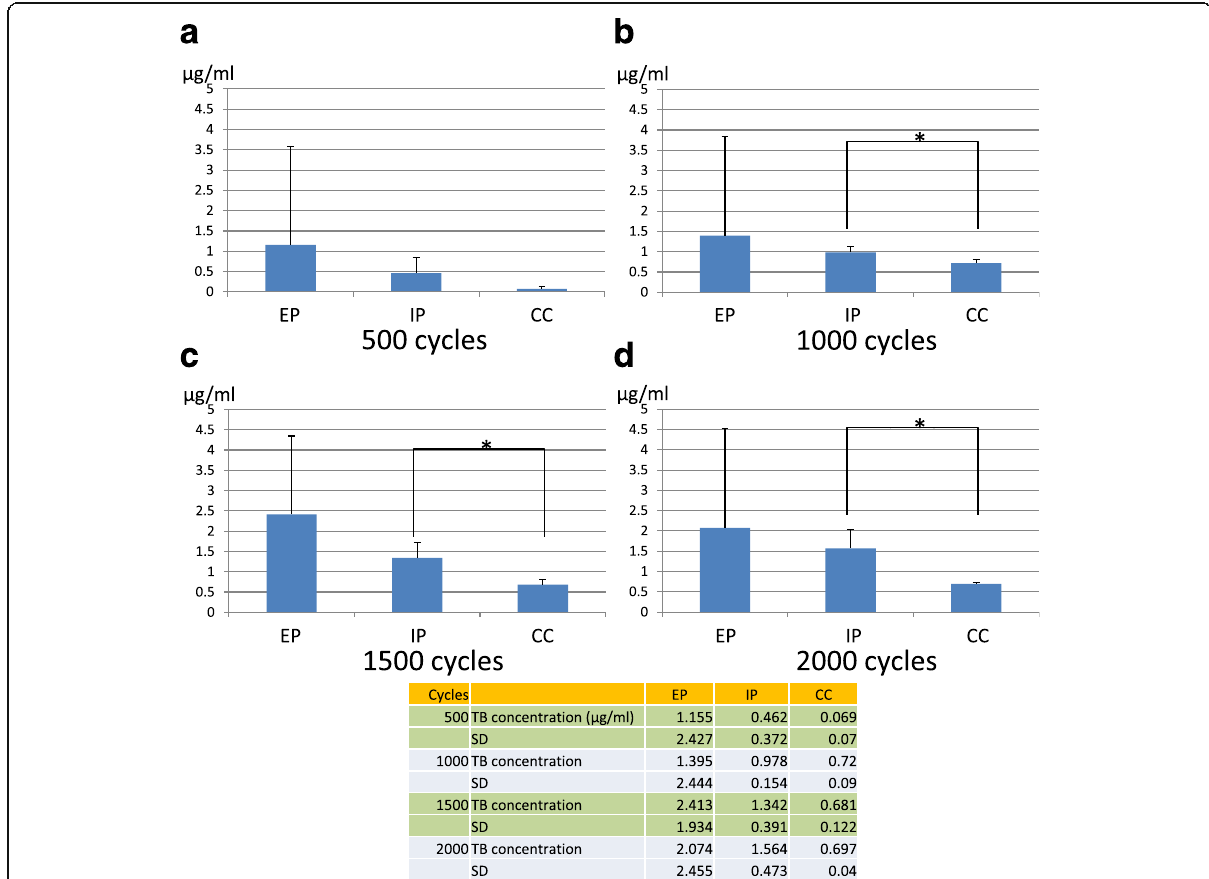
Fig. 4 a Microleakage of toluidine blue from implant – abutment connection at 500 cycles of loading. No statistical difference is indicated ( P >0.05). b Microleakage of toluidine blue from implant – abutment connection at 1000 cycles of loading. c Microleakage of toluidine blue from implant – abutment connection at 1500 cycles of loading. d Microleakage of toluidine blue from implant – abutment connection at 2000 cycles of loading. EP external parallel connection, IP internal parallel connection, CC internal conical connection. Asterisk indicates statistically significant difference ( P